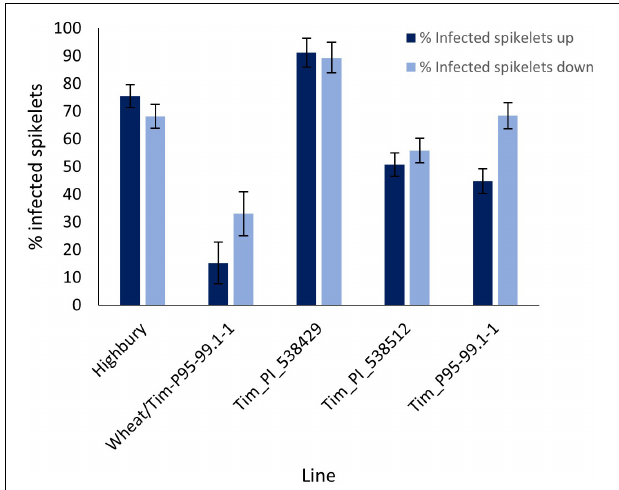
FIGURE 4 | Visual FHB disease score from 2016 trial of three T. timopheevii accessions, T. timopheevii × Highbury amphidiploid (wheat/Tim-P95-99.1-1) and wheat variety Highbury expressed as number of infected spikelets above and below the point of inoculation, 14 days post inoculation with F. graminearum (1 × 10 6 conidia per